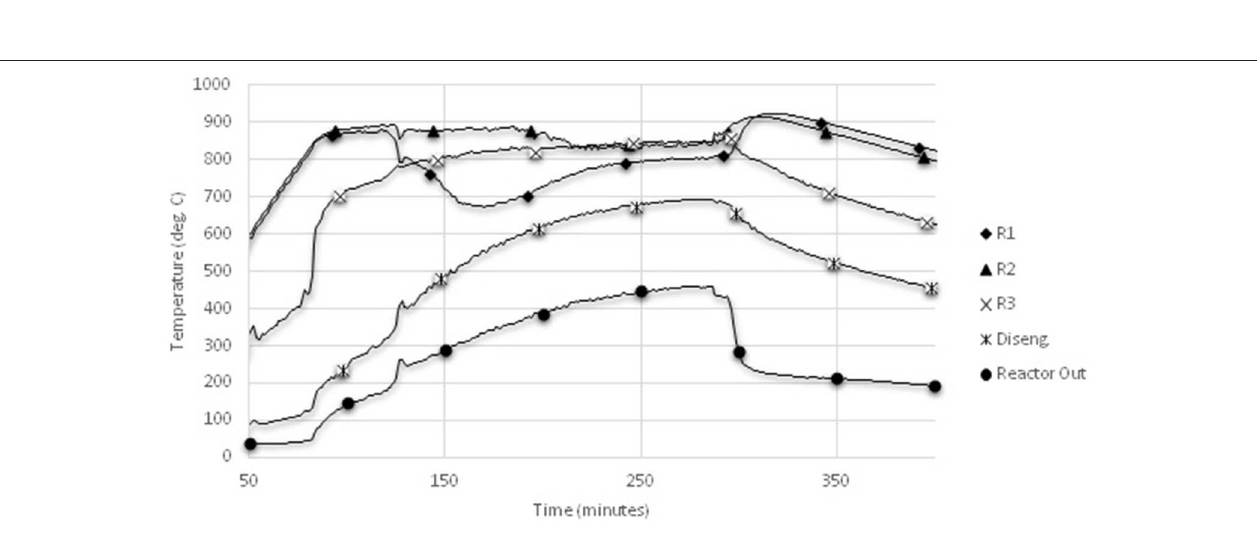
FIGURE 5 | Sample temperature-time profile from steam gasification. Locations of thermocouples R1, R2, R3, disengagement zone, and reactor out locations are shown in Figure 1 .